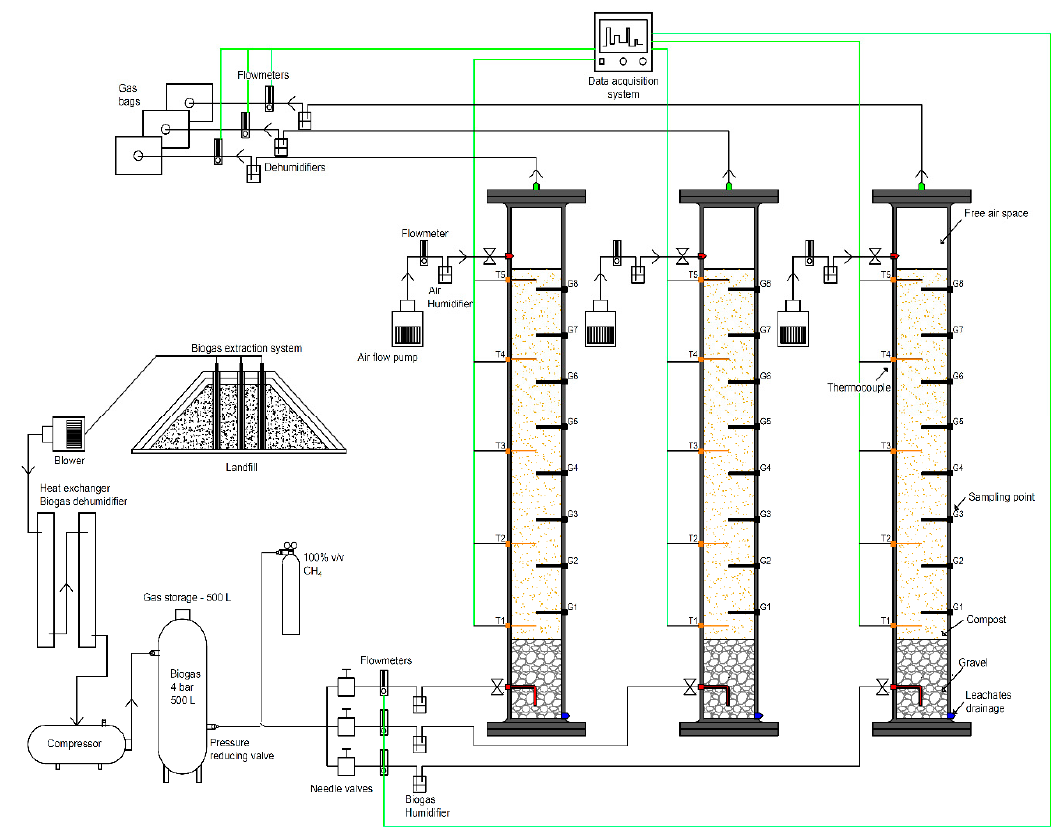
Figure 1. Setup of columns.